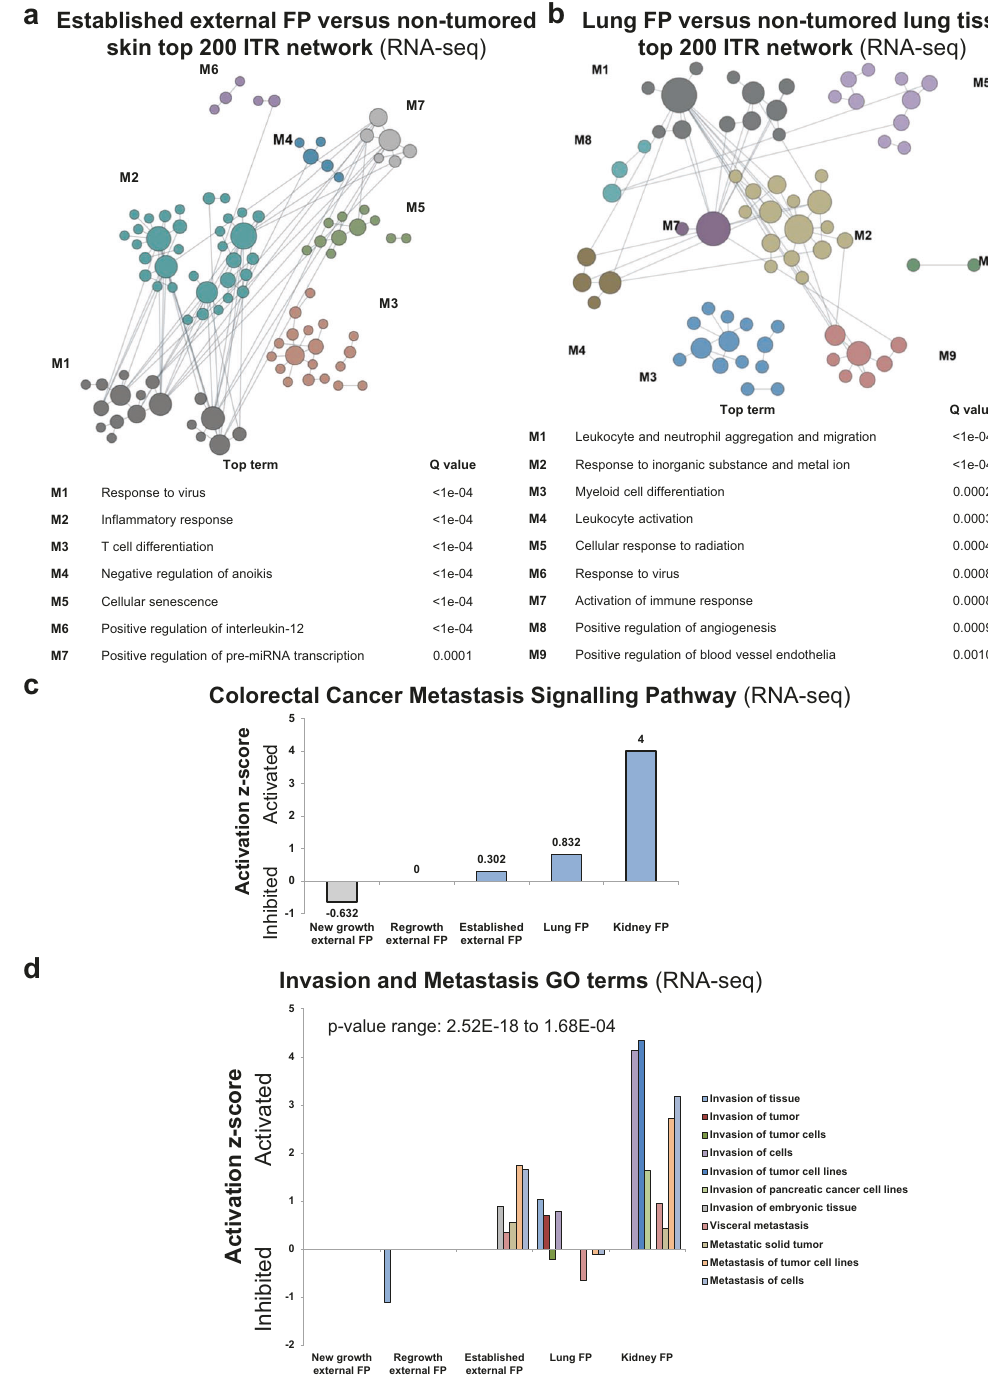
Fig. 5 Network analysis of inferred transcriptional regulator analysis of fi bropapillomatosis tumors. Network-based functional module discovery of the top 200 ranked ITRs (called by IPA) of a established external and b lung tumors. c Activation/inhibition z scores of the ‘ Colorectal Cancer Metastasis Signaling ’ gene ontology (GO) term associated with transcripts differentially expressed in different types of fi bropapillomatosis tumors (kidney FP, lung FP, external FP) when compared to their respective non-tumored tissue sources, as detected by IPA. d Activation/inhibition z scores of 11 invasion and metastasis-associated GO terms from transcripts differentially expressed in different types of fi bropapillomatosis tumors (kidney FP, lung FP, external FP) when compared to their respective non-tumored tissue sources, as detected by